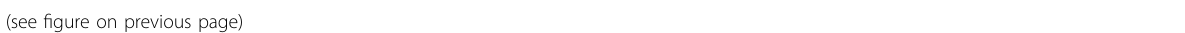
Fig. 5 SNHG1 / hnRNPL complex plays a vital role in PCa metastasis via stabilizing CDH1 mRNA. A CatRAPID fragment prediction revealed that the sequence of SNHG1 at 400 – 600 bp had a signi fi cant binding possibility with hnRNPL (http://service.tartaglialab.com/page/catra-pid_group). B Schematic diagram of 400 – 607 bp truncated mutation in SNHG1 . C Relative quantitative detection of truncated mutation and wild-type SNHG1 overexpression by qRT-PCR. D HnRNPL RIP con fi rmed that knockdown SNHG1 reduced the binding ability of hnRNPL to CDH1, and the overexpression of wild-type SNHG1 could restore the binding ability, while the SNHG1 -mut with poor binding ability of hnRNPL could not rescue hnRNPL to capture CDH1. E , F Effects of overexpression of wild type SNHG1 or mutant SNHG1 on cell migration by wound healing and migration assays. G, H Knockdown of hnRNPL suppressed the mRNA and protein expression of CDH1(E-cadherin). I HnRNPL knockdown in DU145 cells downregulated CDH1(E-cadherin) mRNA abundance, while ActinomycinD (2.0 μ g/ml) were used to inhibit RNA synthesis. All data are shown as the mean ± SD. ** P < 0.01, *** P < 0.001, **** P < 0.0001 by two-tailed Student ’ s t